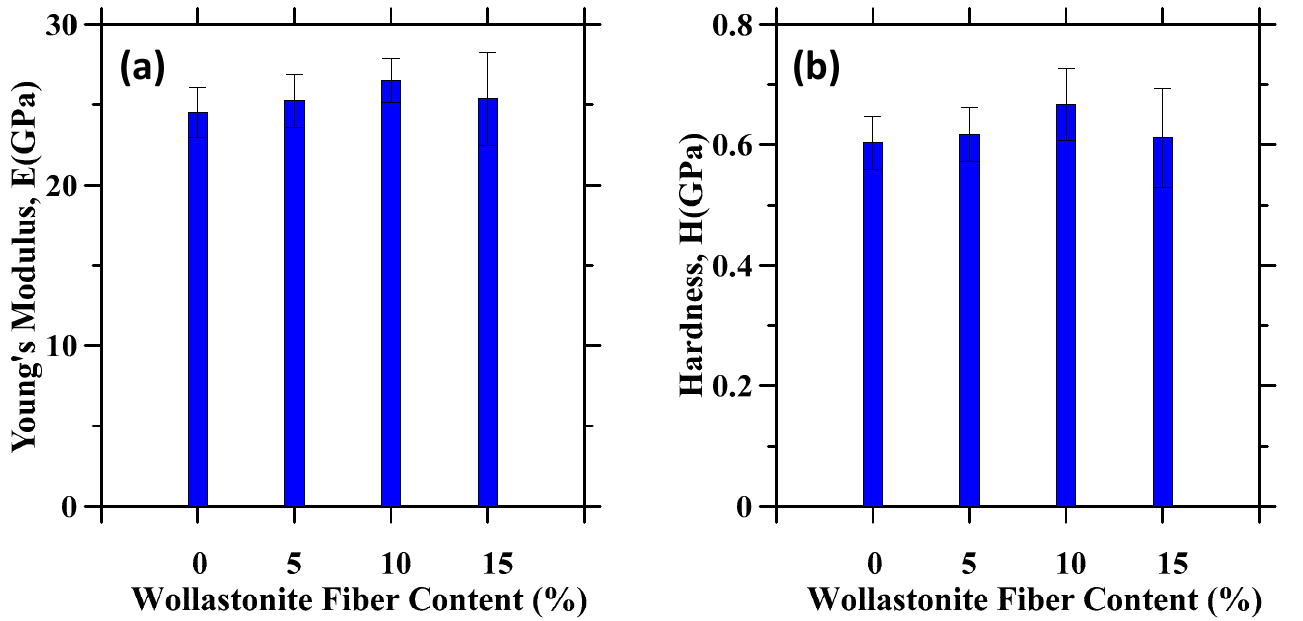
Figure 4. ( a ) The elastic modulus and ( b ) hardness for the system with increasing wollastonite content from the micro-indentation test.